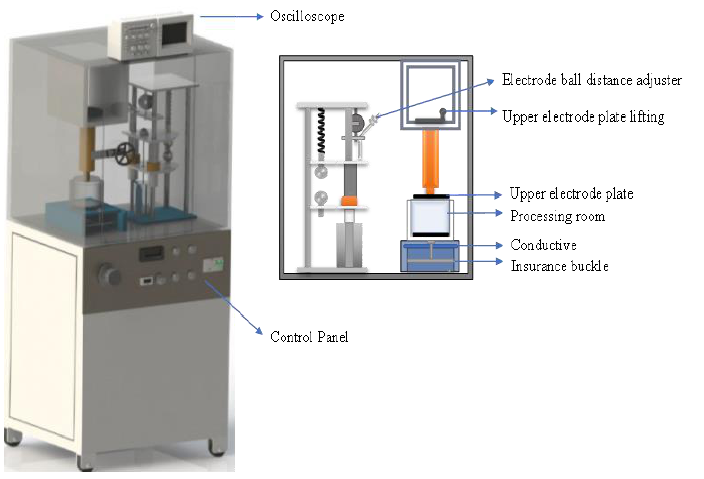
Figure 1. Schematic diagram illustrating the equipment used in batch systems with pulsed electric fields. Table 1. Technical data of the PEF-EX-1900 batch system (Xi-nan Technology Company, China).